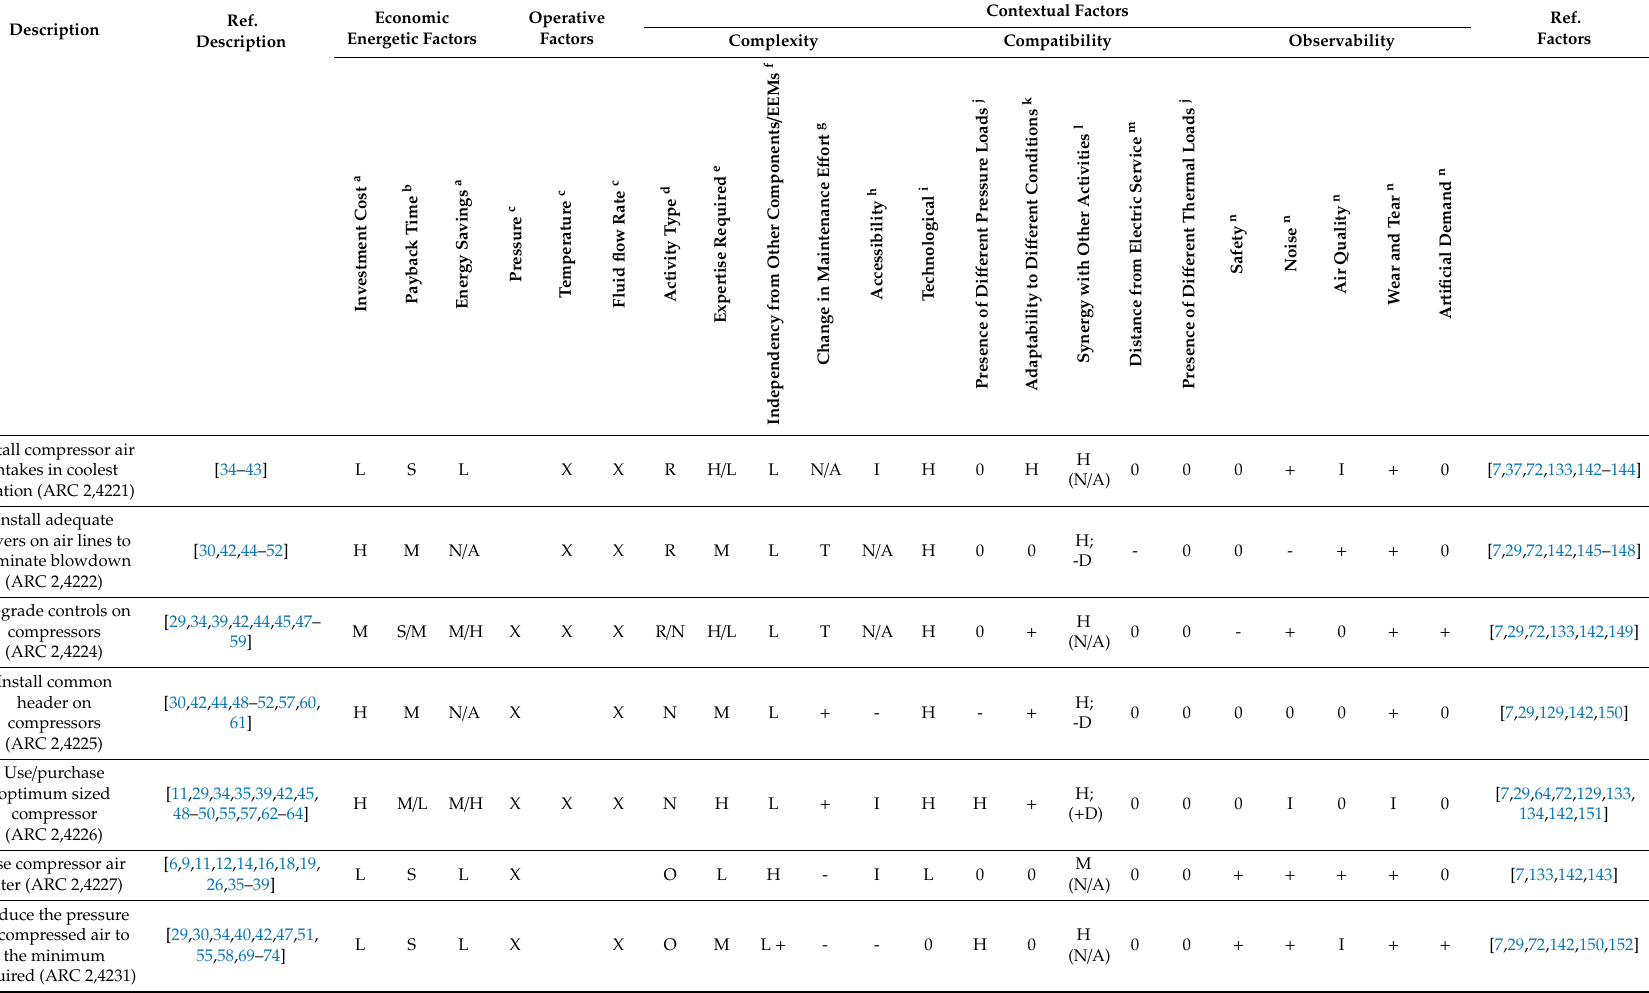
Table 4. Theoretical validation of the